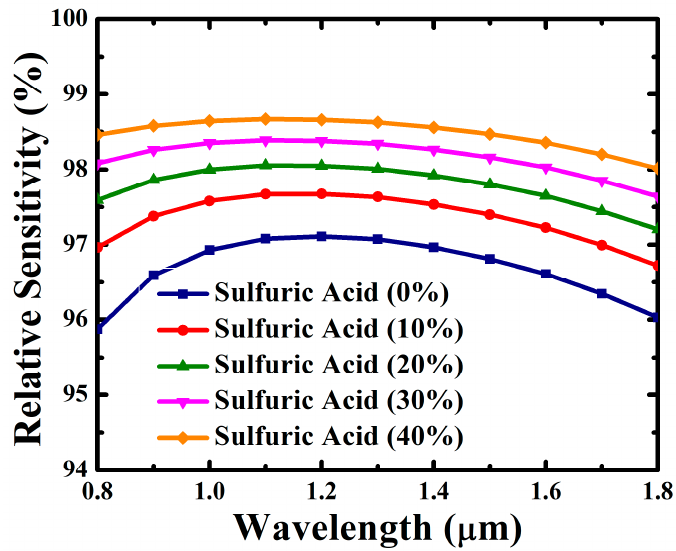
Figure 5. Relative sensitivity of the proposed PCF sensor with 0%, 10%, 20%, 30%, and 40% concentrations of sulfuric acid for different operating wavelengths.